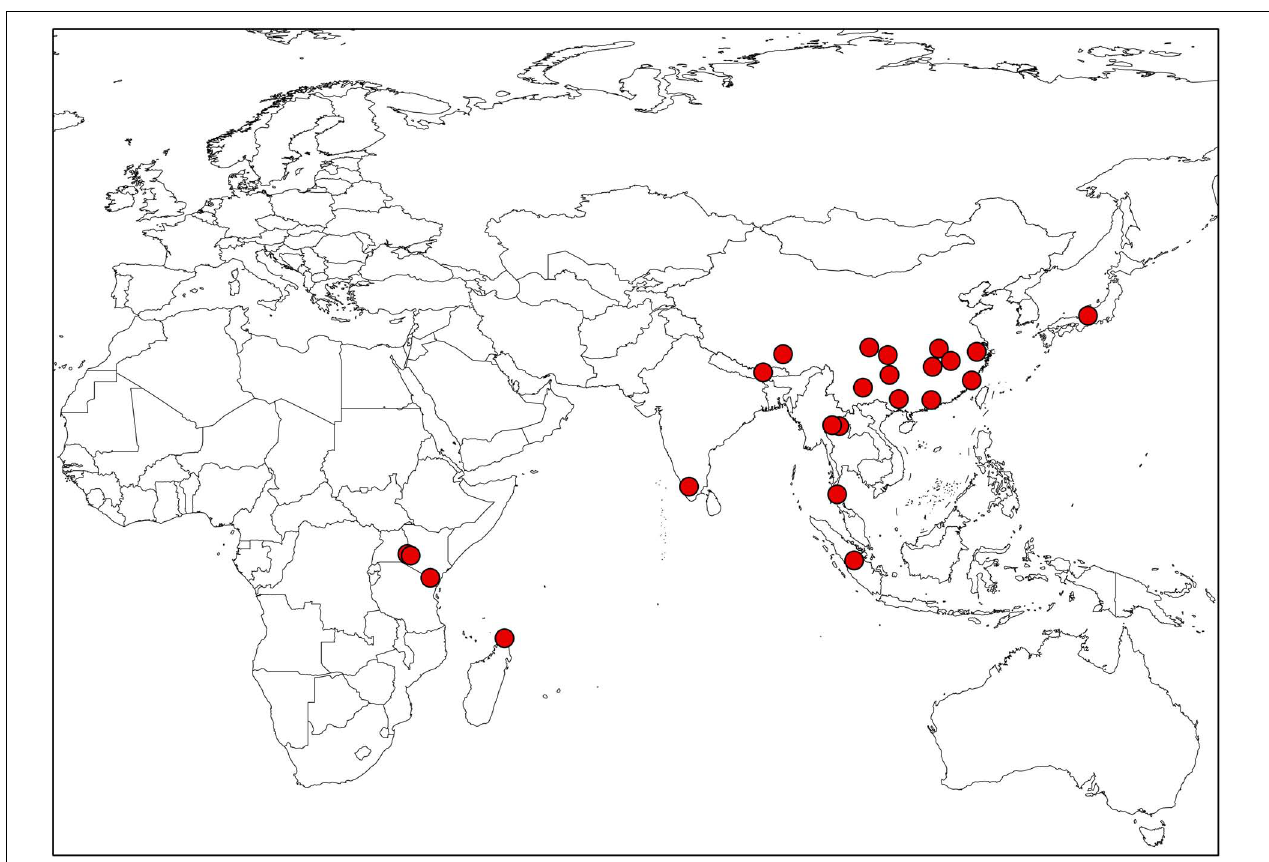
FIGURE 1 | The distribution map of Impatiens in this